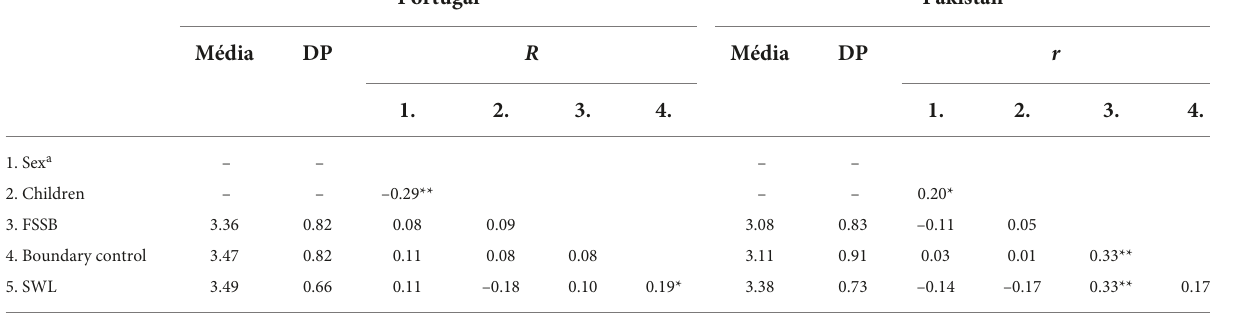
TABLE 1 Mean, standard deviation (SD) and correlations ( N = 226).